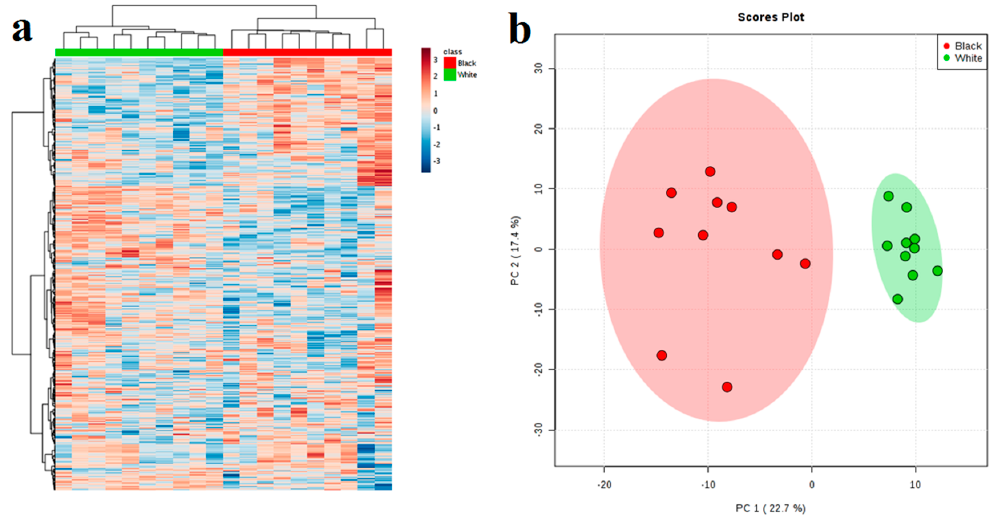
Figure 1. ( a ) Heatmap for black (red block) and white (green block) sesame seeds; ( b ) PCA scores plot for black (red circle) and white (green circle) sesames. Black and white sesame seeds could be completely classified into two classes by using 557 metabolites, indicating that significant differences of metabolites exist between black and white sesame